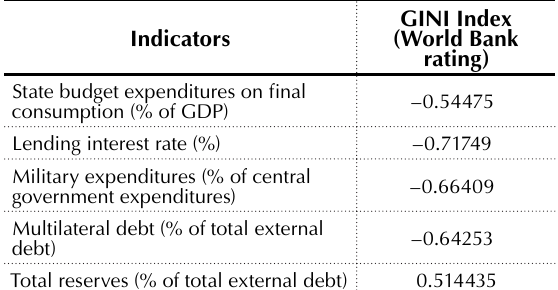
Table 4. Correlation coefficients of the impact evaluation of the national economy in Ukraine on the GINI